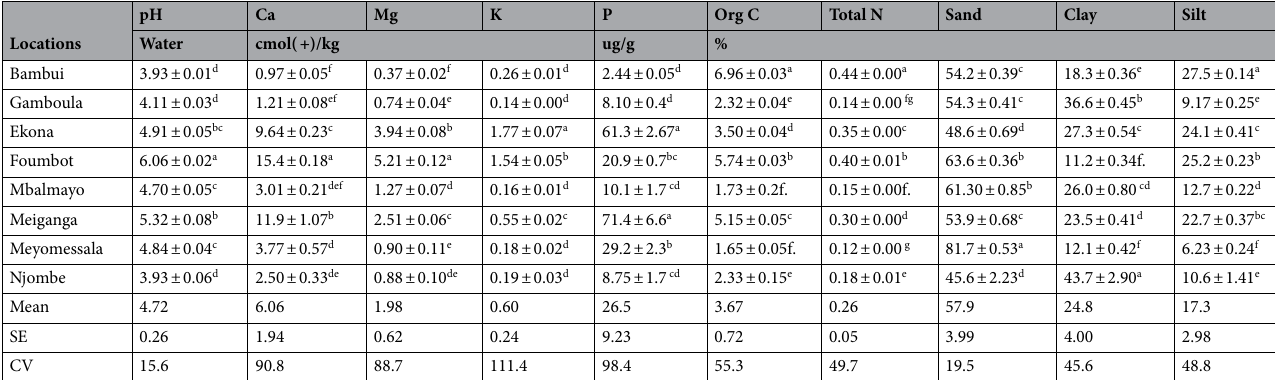
Table 1. Average soil physical and chemical characteristics (± SE). Means in a column followed by the same letter are not significantly different. SE standard error, CV coefficient of